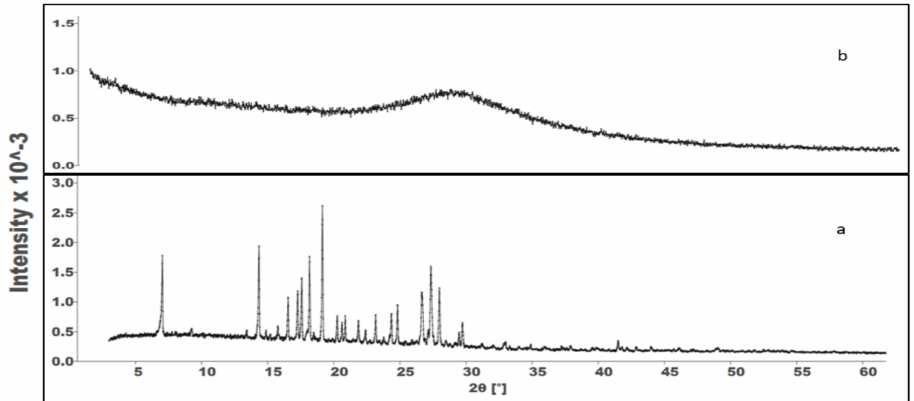
Figure 8. Powder X-ray diffractograms of pure Vox ( a ) and pellet-F1 ( b